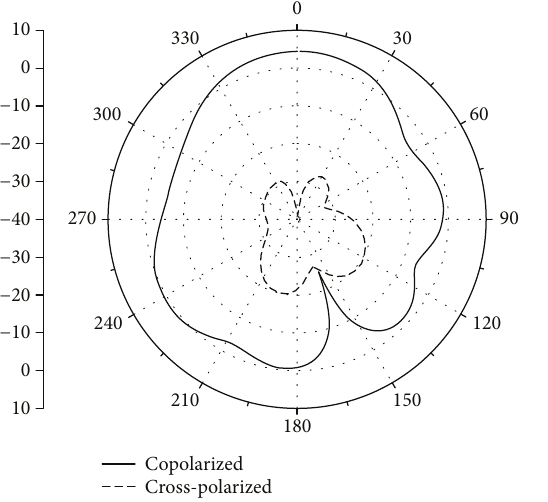
Figure 4: Simulated radiation pattern of the antenna element.